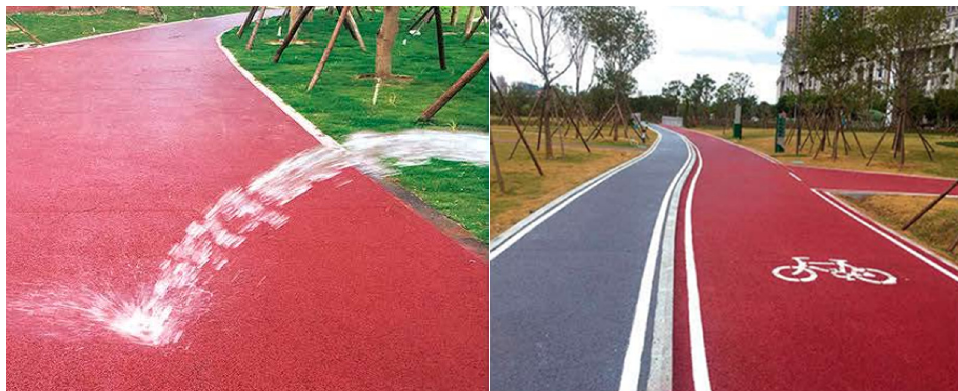
Figure 4. Site images of the permeable pavement in the Riverside Park.